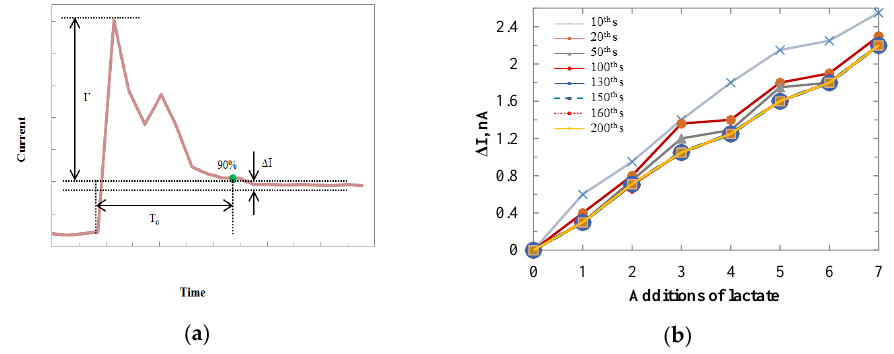
Figure 5. Time-current plot for the enzyme coated Au electrode in 1× PBS with the response to lactate addition. Each addition is 2 mM. The arrows indicate additions of lactate solution.